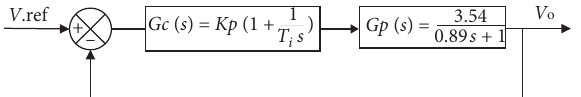
Figure 7: Closed-loop control system with PI controller designed by pole placement method.